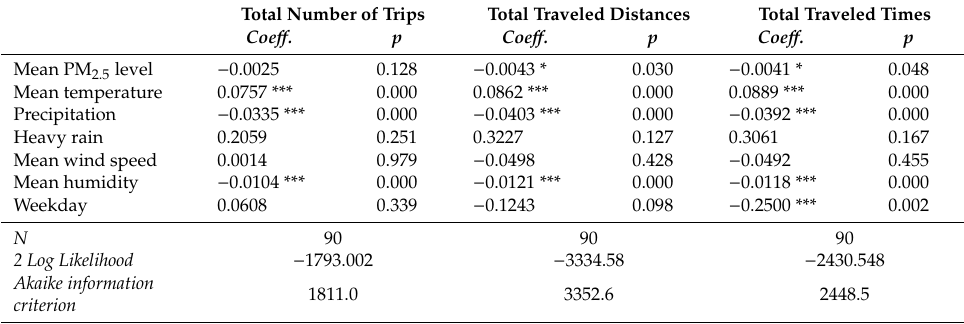
Table 6. Estimation results for bike sharing use using PM 2.5 level data in spring.